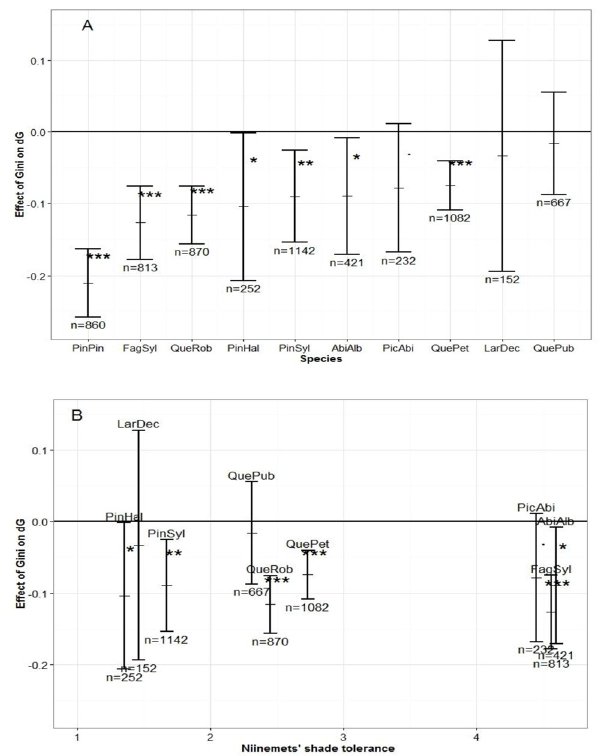
Fig 2. Effect of Gini coefficient ( δ from Eq 3) on productivity (dG). The results are presented according to species sensitivity to size heterogeneity (A) or to their shade tolerance (B). Pinus Pinaster was removed from (B) because there is no shade tolerance value in Niinemets & Valladeres (2006). Levels of significance are indicated on the graph based on a log-likelihood ratio test: (.) p -value < 0.1, ( * ) < 0.05, ( ** ) < 0.01, ( *** ) < 0.001. p -values are available in S3 Appendix for all variables.